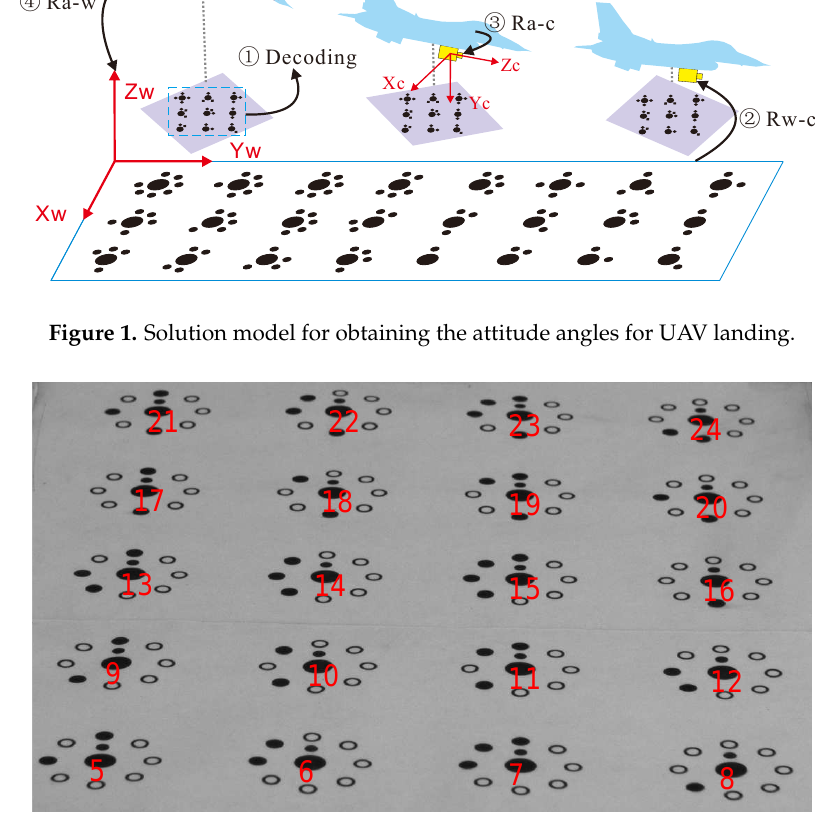
Figure 2. Code target decoding